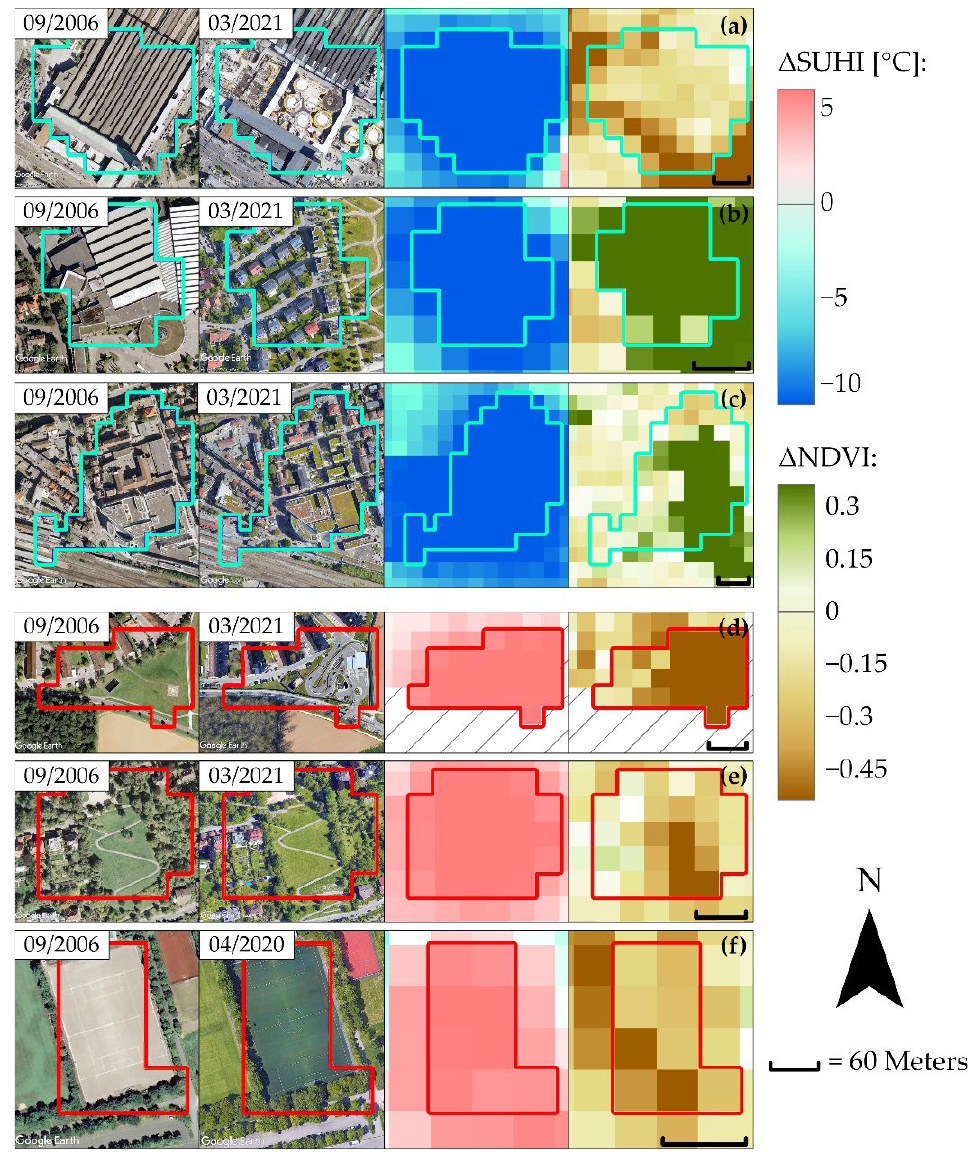
Figure 5. Six examples for cooling (blue) and warming spots (red) identified in Stuttgart with the respective changes in surface urban heat island (ΔSUHI) and Normalised Difference Vegetation Index (ΔNDVI). Examples are: ( a ) material changes at the construction site of Stuttgart’s new central station (Stuttgart 21), ( b ) replacement of a large industrial hall by houses with vegetation, ( c ) green roof retrofit on existing and new buildings (note the presence of artefacts in the bottom left corner), ( d ) removal of trees and sealing of grassland with asphalt, ( e ) potential impacts of decreased evapotranspirative cooling on grassland due to a decrease in vegetation health, and ( f ) replacement of a tennis court surface by artificial turf. Note that images are recorded in different seasons, which might influence the vegetation coverage displayed. Missing data for ΔSUHI and ΔNDVI is marked as hatched.